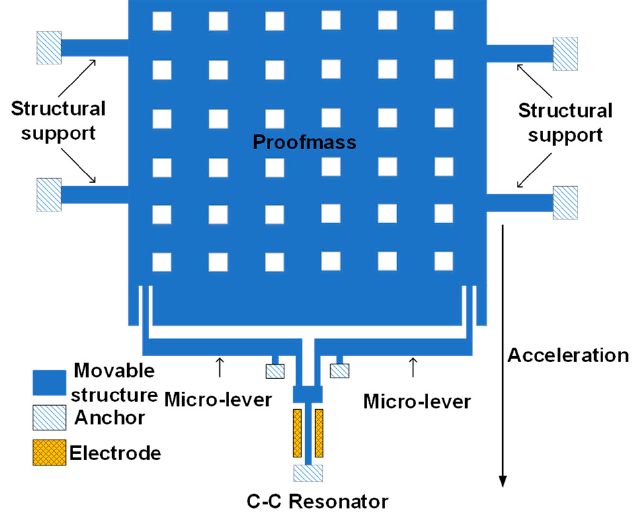
Figure 2. The schematic of our silicon-based MEMS accelerometer. The tune fork resonator is an accelerometer sensor, which is driven and sensed by capacitors. The proof mass has four structural supports and a pair of micro-levers.